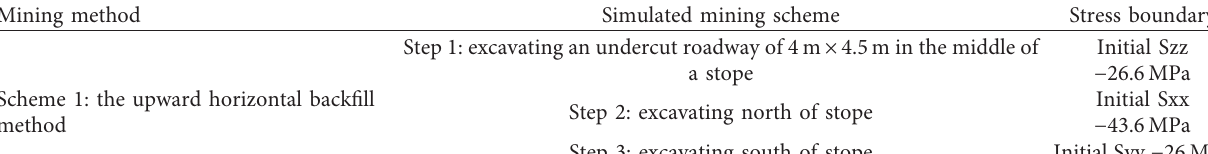
Table 2: Designed mining schemes of test stope. Mining method Simulated mining scheme